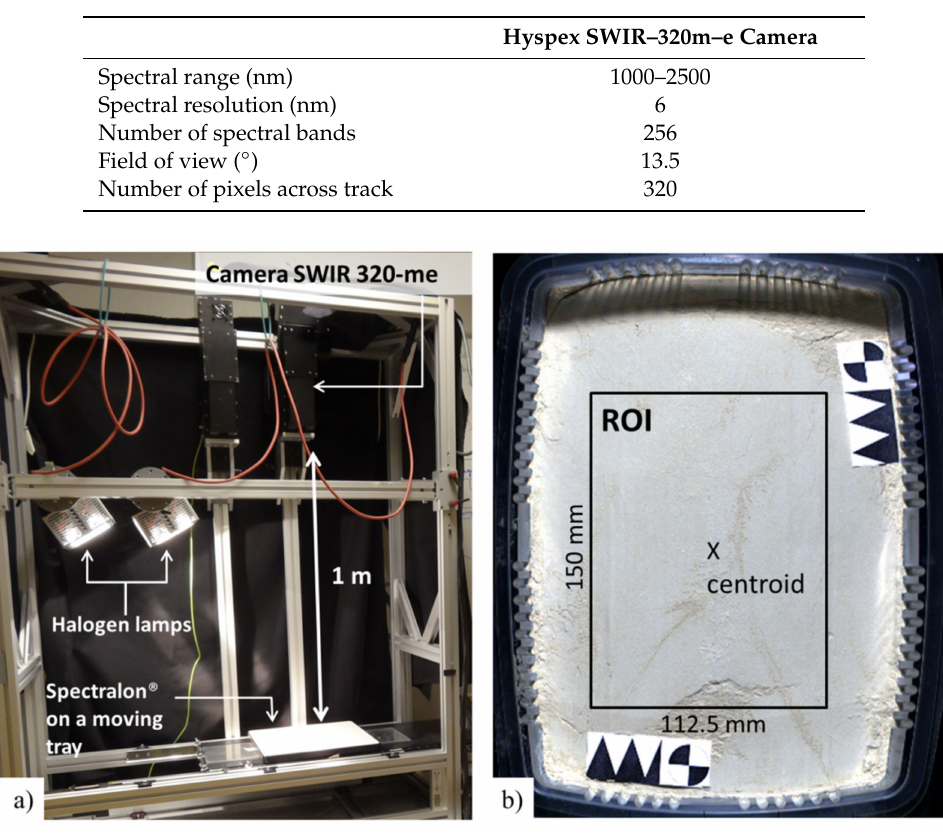
Figure 2. ( a ) Laboratory setup and ( b ) RGB composite image of a mixture sample with the region of interest (ROI) selected for the study (black